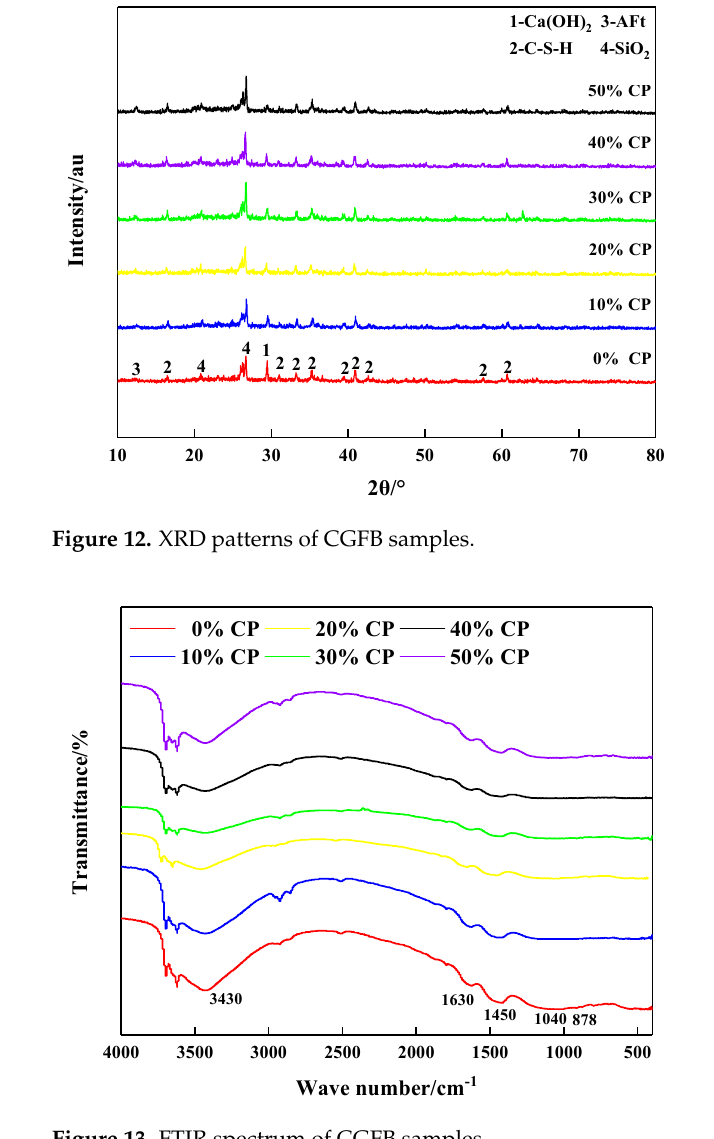
Figure 12. XRD patterns of CGFB samples.